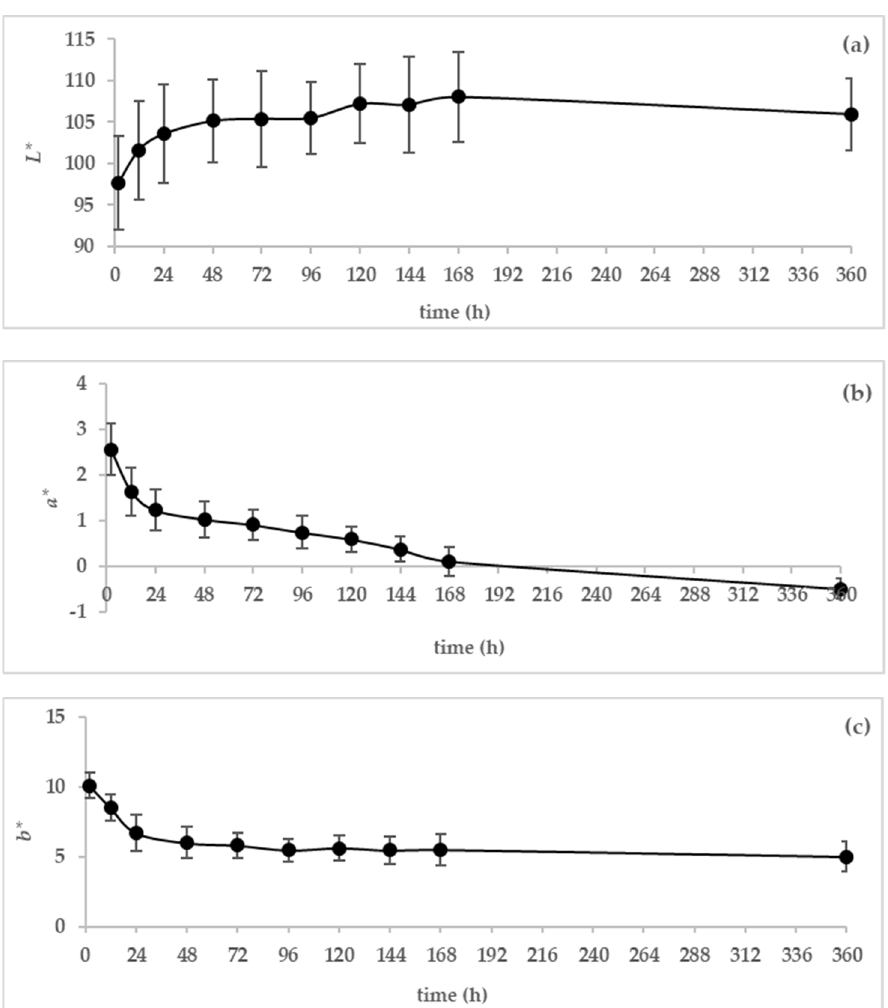
Figure 3. Variation in color parameters of dromedary camel colostrum and milk during the first 7 days and on day 15 postpartum ( n = 16), ( a ) L* (lightness), ( b ) a* redness, and ( c ) b*